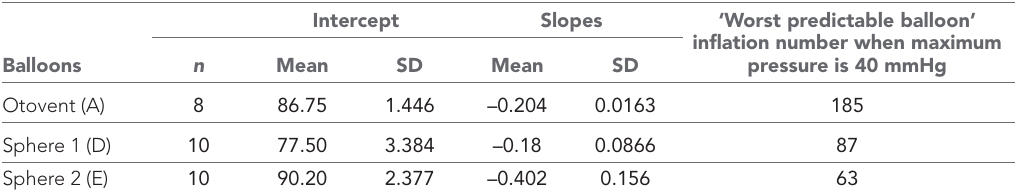
Table 3 Mixed- effect model for inflation numbers 2–50: results and inflation number of 'worst pre- dictable' balloon for Otovent (A), sphere 1 (D), and sphere 2 (E).